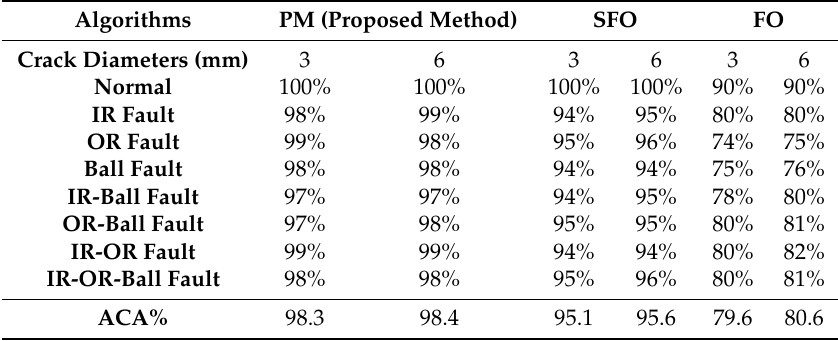
Table 10. The multi-fault diagnosis accuracy for 450 RPM torque speed.